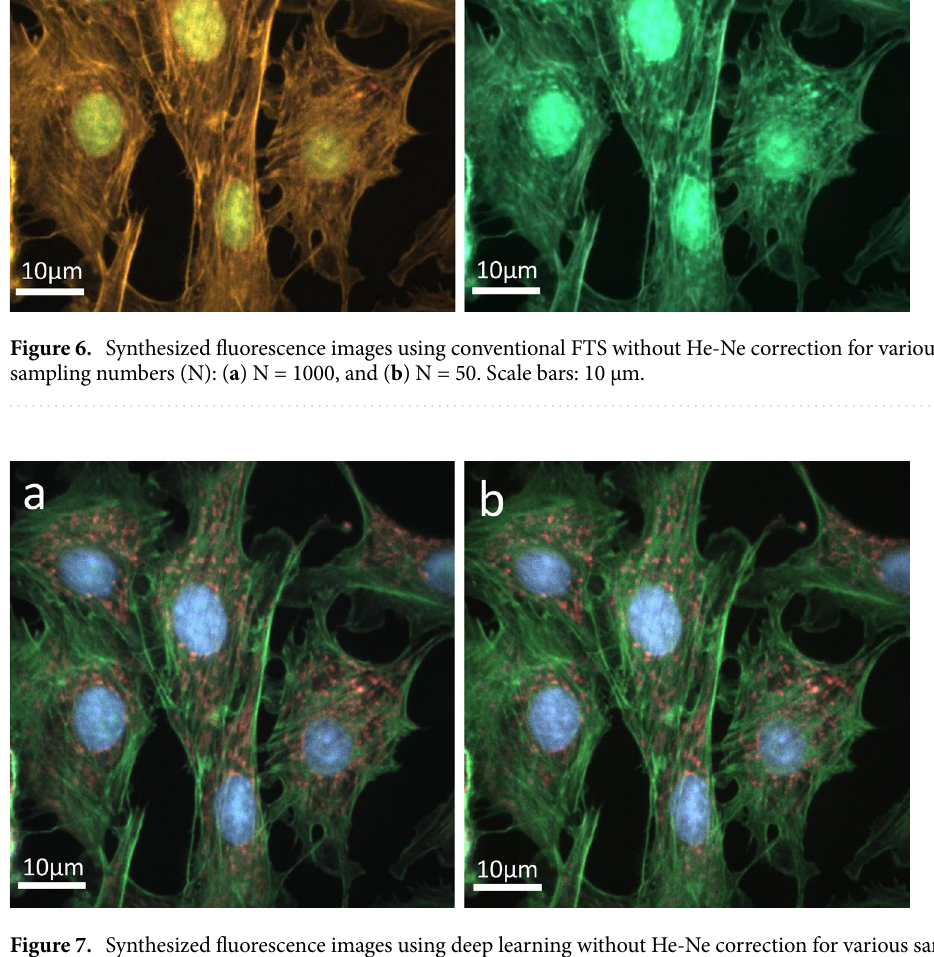
Figure 7. Synthesized fluorescence images using deep learning without He-Ne correction for various sampling numbers (N): ( a ) N = 1000, and ( b ) N = 50. Scale bars: 10